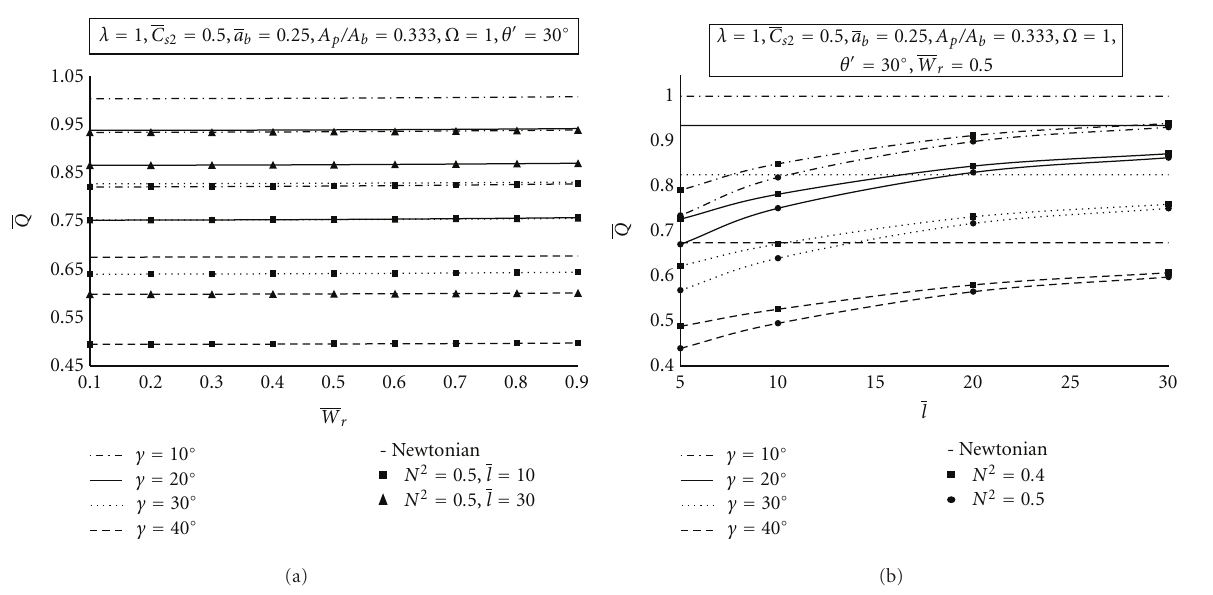
bearing configurations for either the lubricants on the